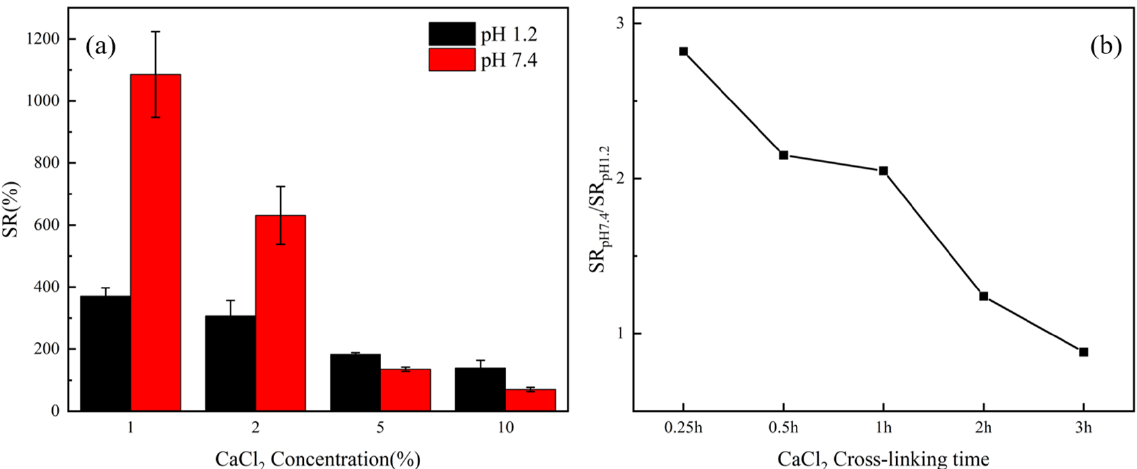
Figure 4. Effects of calcium ion crosslinking time on pH-responsive properties of hydrogels. ( a ) Swelling rate of hydrogels crosslinked with CaCl 2 for different crosslinking times at pH 1.2 and pH 7.4. ( b ) Ratio of the swelling rate of hydrogels at pH 1.2 and pH 7.4 as a function of CaCl 2 crosslinking time.